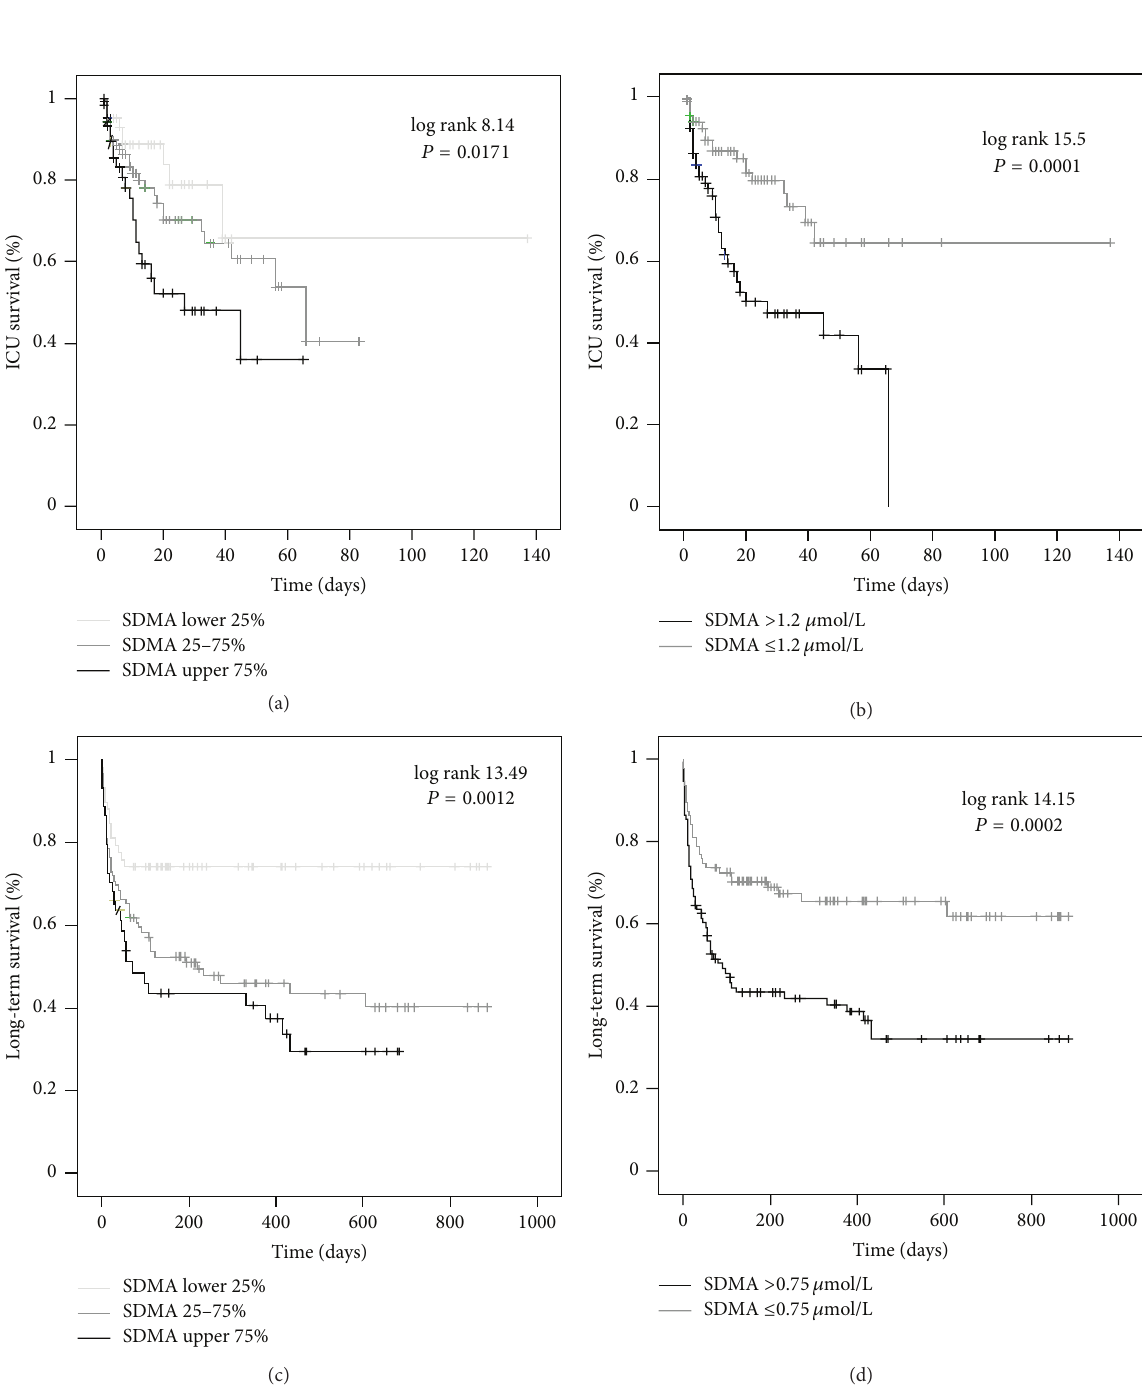
Figure 3: Prediction of mortality by SDMA serum concentrations. ((a)-(b)) Kaplan-Meier survival curves of ICU patients are displayed, showing that patients with SDMA levels of upper quartile (on admission > 1.7 𝜇 mol/L; black (a)) had an increased short-term mortality at the ICU as compared to patients with ADMA serum concentrations of lower quartile (on admission < 0.51 𝜇 mol/L; light grey) or middle 50% (grey). Best discrimination between ICU survivors and nonsurvivors was achieved with an SDMA cutoff value of 1.2 𝜇 mol/L (b). Log rank and 𝑃 values are given in the figure. ((c)-(d)) Kaplan-Meier survival curves of ICU patients are displayed, showing that patients with SDMA levels of upper quartile (on admission > 1.7 𝜇 mol/L; black (c)) had an increased long-term mortality at the ICU as compared to patients with SDMA serum concentrations of lower quartile (on admission < 0.51 𝜇 mol/L; light grey) or middle 50% (grey). Best discrimination between overall survivors and nonsurvivors was achieved with an ADMA cutoff value of 0.75 𝜇 mol/L